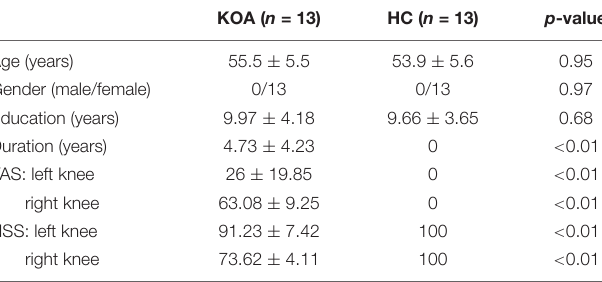
TABLE 1 | Characteristics of demographic and clinical